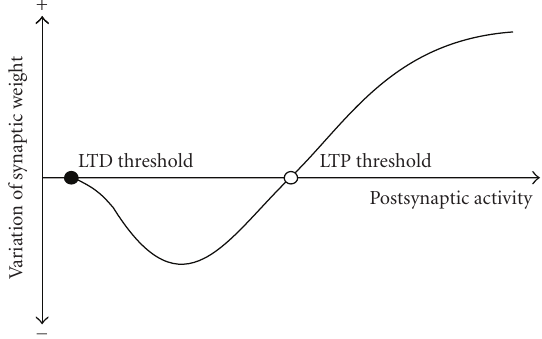
Figure 3: Variation of synaptic e ffi ciency (synaptic weight) in terms of postsynaptic activity. For levels of postsynaptic activity above the LTP threshold, synaptic potentiation (positive variation of synaptic weight) takes place. Between the LTD and LTP thresholds, synaptic depression (a negative variation of synaptic weight) occurs. Below the LTD threshold there is no variation of synaptic e ffi